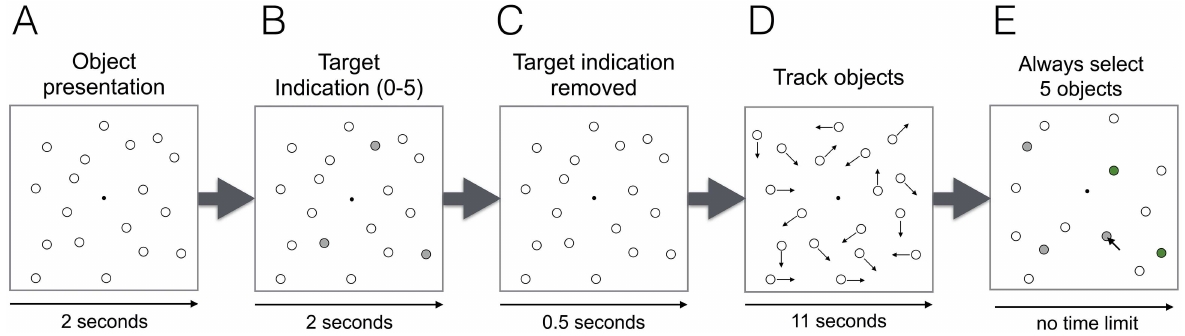
Fig 1. Multiple object tracking (MOT) task trial overview. (A) Objects (total: 18) are shown. (B) A subset of objects (i.e., the “targets”, variedbetween zero and five) turn gray for two seconds. Note that in the passive viewingcondition(zero targets), no objects turn gray in this phase. (C) The target indication is removed. Targets are now indistinguishablefrom the other objects. (D) Objects randomly move across the screen and participants need to track the movements of the targets. Arrows indicate the current movementdirectionof the objects. (E) The objects stop moving and participantsselect the targets using the mouse. To keep motor demandsconstant, participants alwaysneed to select five objects but only the first selectionscount to performance (e.g., if two targets need to be tracked, then only the first two selectionscount to performance). After five objects are selected, feedbackis given (i.e., correct selectionsturn